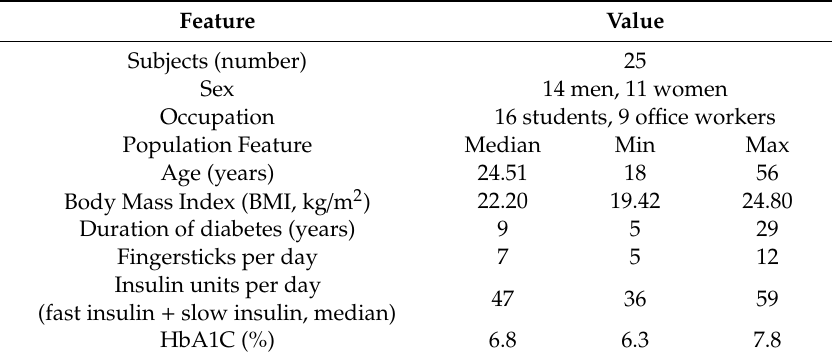
Table 1. Data regarding the patients considered in the